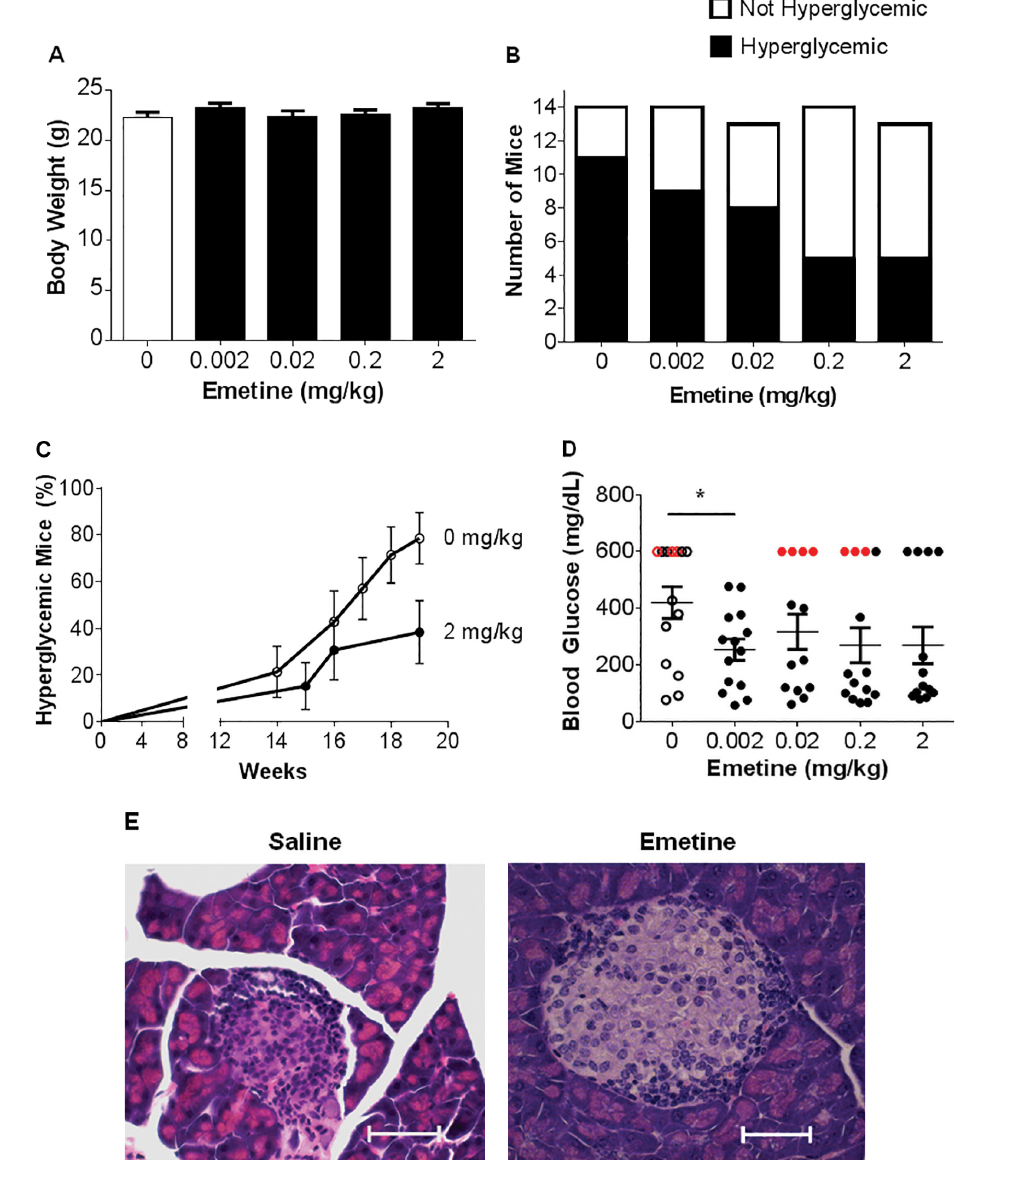
Figure 5. Emetine improves disease severity in a spontaneous model of NOD T1D. (A) Emetine administration did not induce any signifi- cant changes in body weight. Body weights collected at the end of the study (19 wks) are shown here. (B) Emetine dose-dependently protects animals from hyperglycemia. Total number of animals, at wk 19, developing hyperglycemia is shown here. Mice with blood glucose levels above 200 mg/dL were considered hyperglycemic, p = 0.01. (C) Time course of the percent of mice that are hypergly- cemic (200 mg/dL) in saline and emetine (2 mg/kg) treated animals, p = 0.02. (D) Individual blood glucose levels measured at 19 wks of age. Red data points signify the last measured blood glucose level of mice that did not survive until the end of the study. (E) Repre- sentative images of hematoxylin & eosin (H&E) stained pancreatic islets of Langerhans from either saline or emetine (0.2mg/kg) treated animals. Scale bar, 50 μ m. (F) Insulitis scores of top slice of H&E stained pancreatic islets from saline and emetine (0.2 mg/kg) treated animals, p = 0.0037. (G) Percentage of total islets are sectioned into score categories, p < 0.0001. (H) Emetine induces significant atten- uation of pancreatic TNF levels. (A-D) 0 mg/kg (n = 14), 0.002 mg/kg (n = 14), 0.02 mg/kg (n = 13), 0.2 mg/kg (n = 14), 2 mg/kg (n = 13). (H) 0 mg/kg (n = 12), 0.002 mg/kg (n = 14), 0.02 mg/kg (n = 11), 0.2 mg/kg (n = 12), 2 mg/kg (n = 13). (F, G) n = 4 (islets: saline = 29, emetine = 48). Data are mean ± SEM. Statistical analysis was measured by (A and D, H) one-way ANOVA, (B) chi-square test for trend, (C) Kaplan-Meier curve with a log rank test for trend, (G) chi-square test, and (F) Student t test, p ≤ 0.05(*). Continued on the next